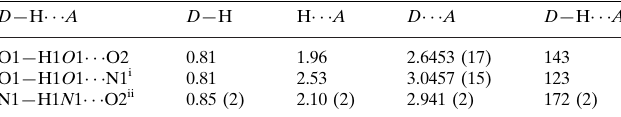
Hydrogen-bond geometry (A˚ , (cid:2)